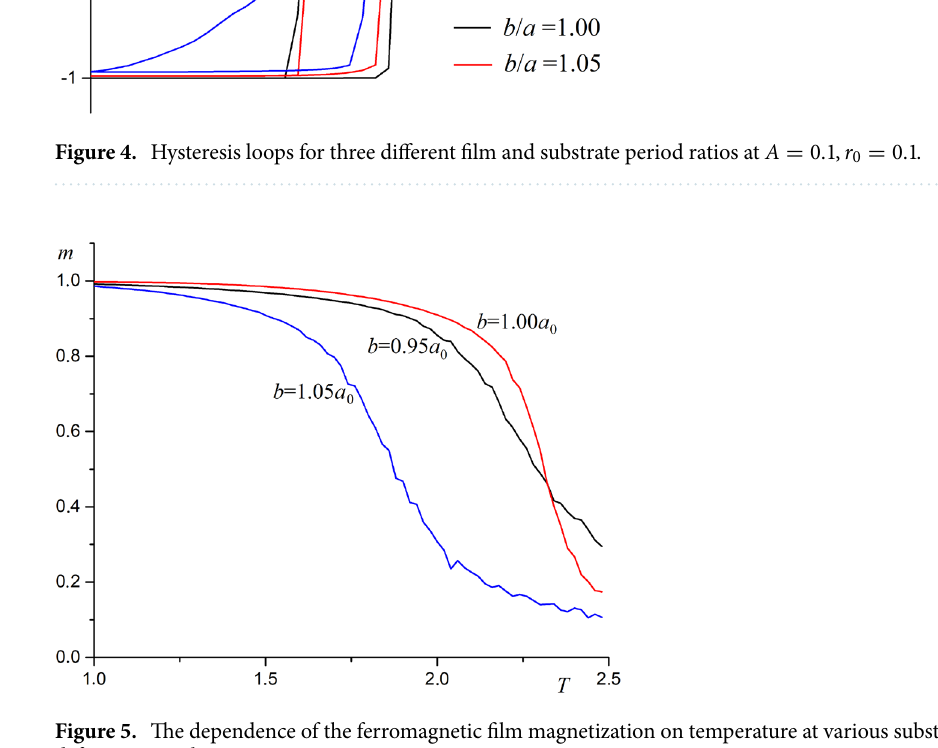
Figure 5. The dependence of the ferromagnetic film magnetization on temperature at various substrate deformation values at A = 0.1 , r 0 = 0.1